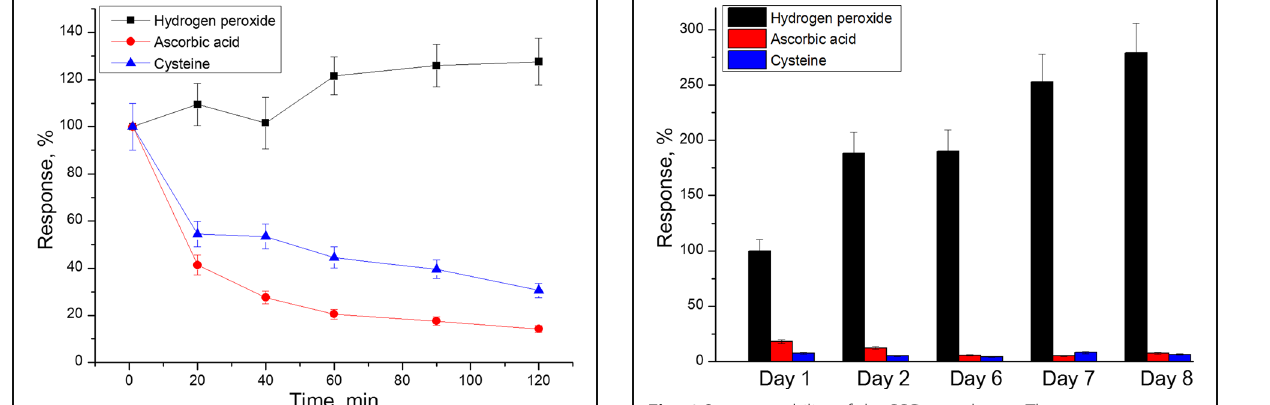
Fig. 6 Storage stability of the PPD membrane. The responses were normalized to response to H 2 O 2 at the first day 2 min, the membrane deposition on one sensor took 6 min.